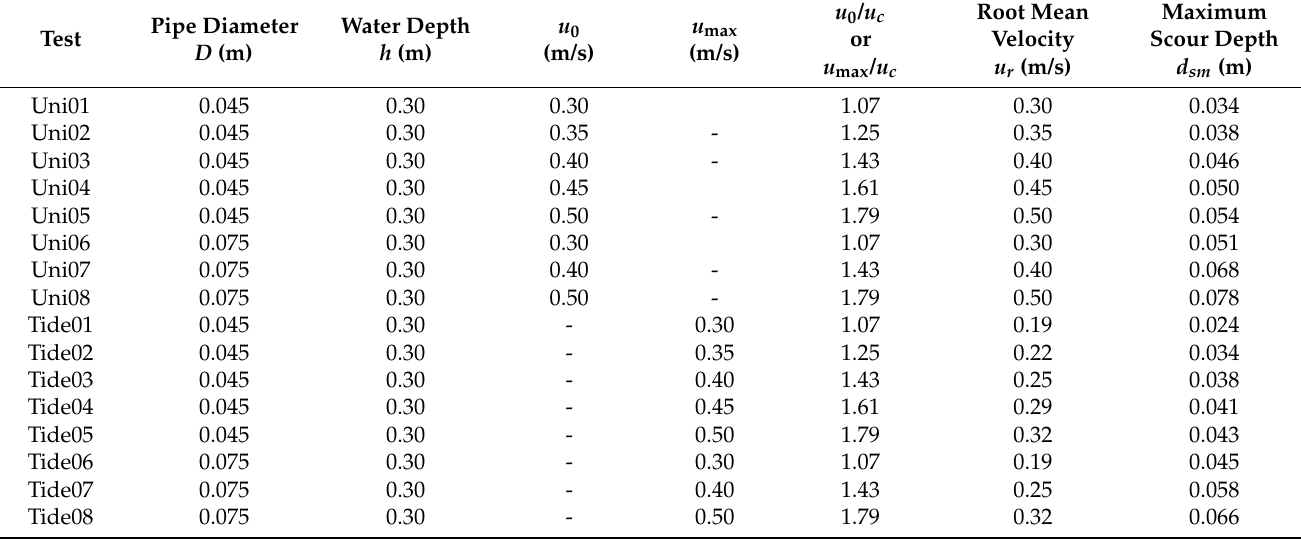
Table 1. Parameters of the experiments for unidirectional and bidirectional tidal